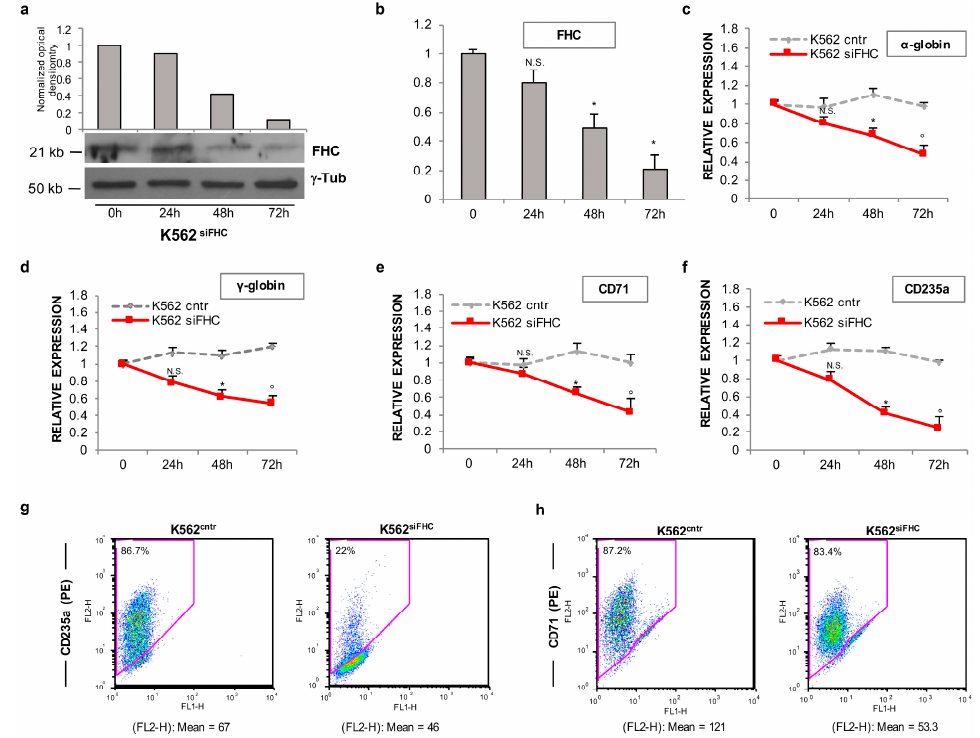
Figure 2. Transient FHC silencing down-regulates erythroid markers expression in K562 cells. FHC amounts of K562 cells at 0, 24, 48 and 72 h after a transient transfection of a specific FHC siRNA at protein ( a ) and mRNA ( b ) levels; Data represent mean ± SD ( n = 3). * p < 0.05 compared with 0 h, N.S.: not significant. The relative expression of α -globin ( c ); γ -globin ( d ); CD71 ( e ) and CD235a ( f ) in K562 siFHC cells at each time point was measured using qRT-PCR. Data represent mean ± SD ( n = 3). * p < 0.05 compared with K562 cntr at 48 h; ° p < 0.05 as compared with K562 cntr at 72 h; N.S.: not significant. Flow cytometry analysis of CD235a- ( g ) and CD71- ( h ) positive cells in K562 cntr and K562 siFHC cells at 72 h upon FHC siRNA transfection. Data are reported both as mean fluorescence intensity of CD235a and CD71 (FL2-H) and as percentage (%) of CD235 + and CD71 + cells. Taken together, these results indicate that ferritin heavy subunit knockdown is able to strongly inhibit the erythroid transcriptional program in K562 cells, and to almost completely abrogate the appropriate intracellular amounts of FHC are needed for the correct expression of these key genes.